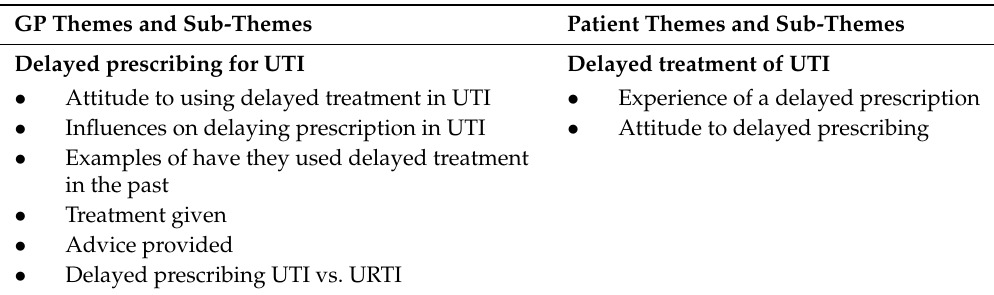
Table 2. Example of the themes and sub-themes emerging from analysis. GP Themes and